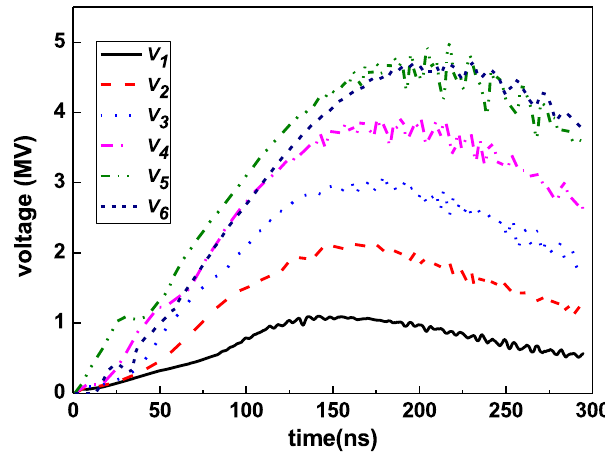
FIG. 4. Anode to cathode voltages obtained from PIC simu- lation. The voltages were observed after each LTD group and after the final conical line for a self-limited magnetic insulation. Results indicated voltage could be effectively summed up and a maximum value of 4.6 MV could be obtained at the final